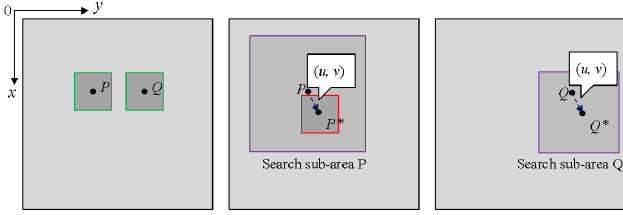
Figure 6. Adaptive adjustment of search areas.